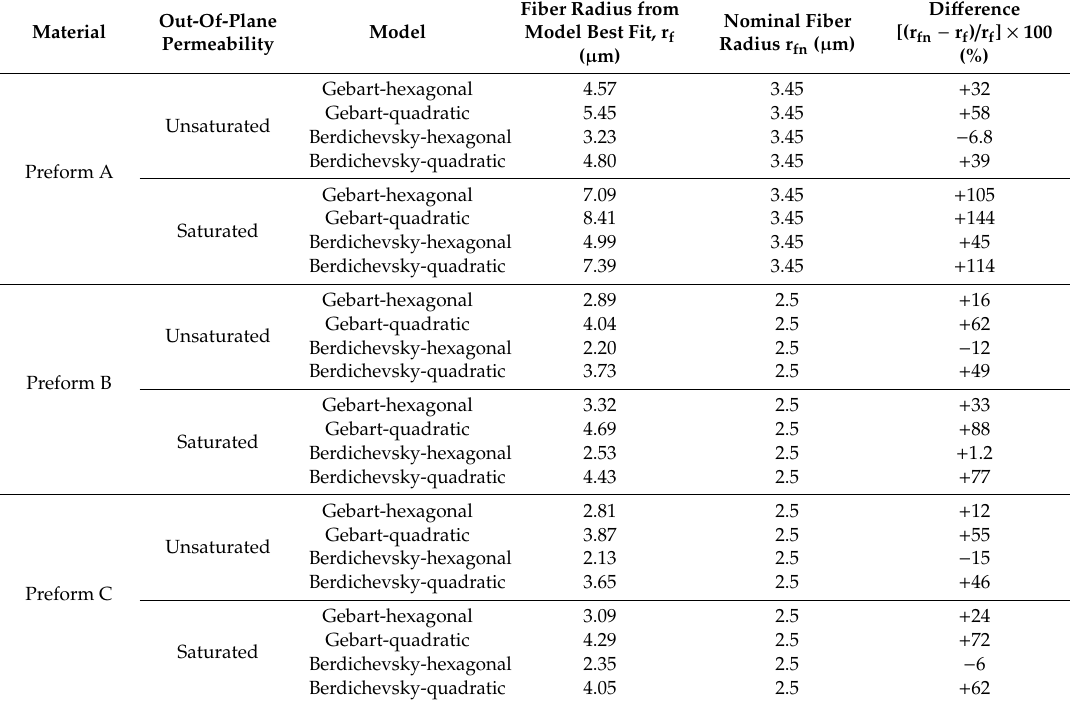
Table 4. Unsaturated out-of-plane fiber radius obtained from the mathematical modeling of the experimental K 3 values and percentage di ff erence from the nominal fiber